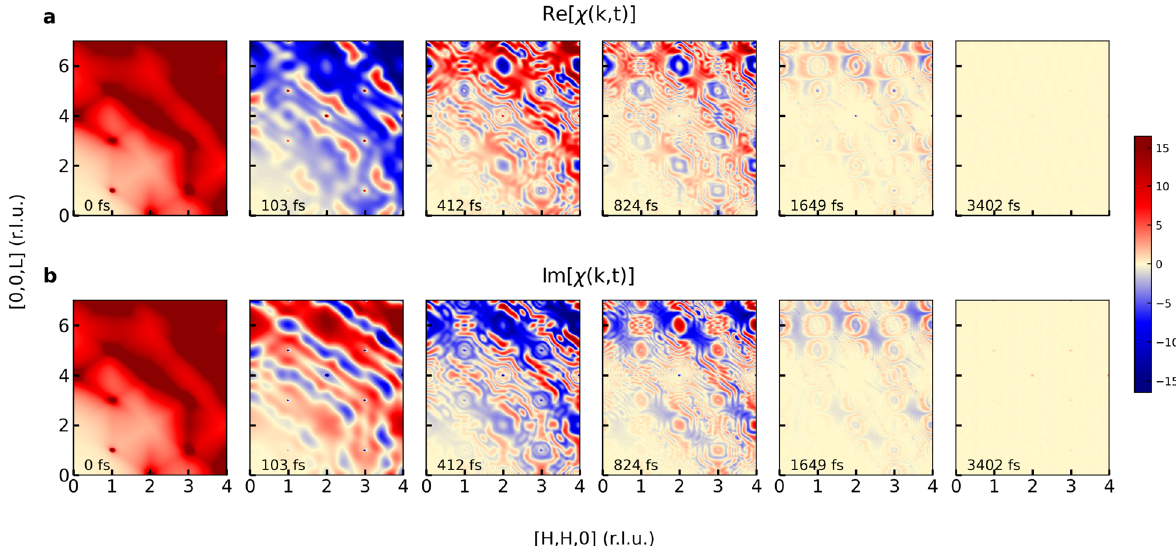
Fig. 1 Response function χ (k, t ) at different instances. Snapshots of a real and b imaginary parts of χ ( k , t ) at 0, 103, 412, 824, 1649, and 3402 femtoseconds (fs). χ ( k , t ) is shown in the ( H , H , L ) reciprocal plane. The contour plots are normalized to their maximum intensity. The lattice dynamics dies out at longer time